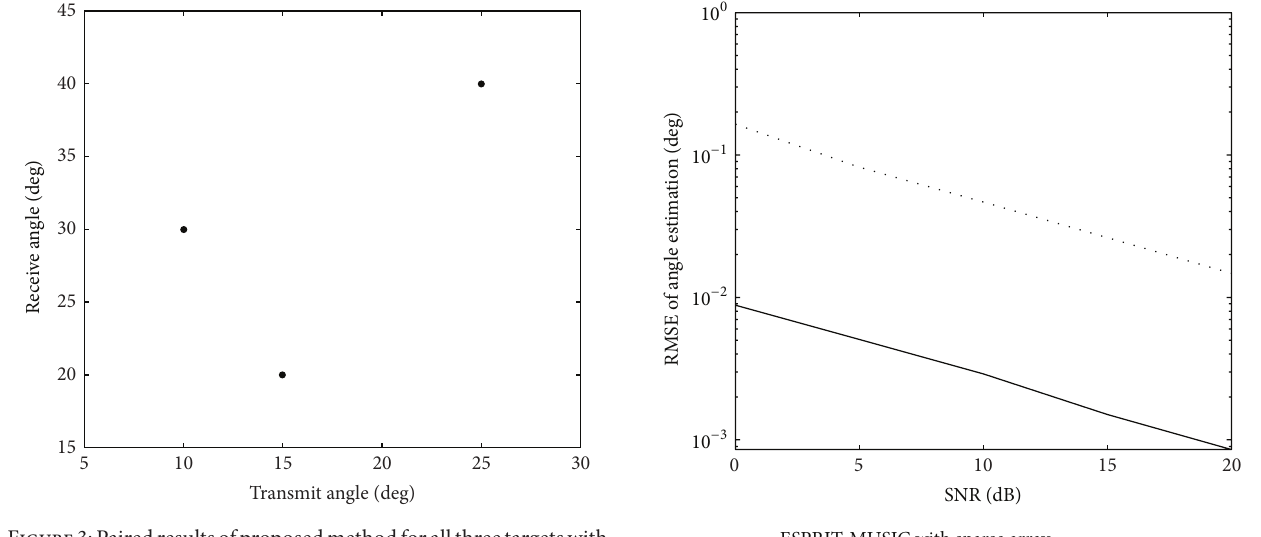
Figure3:Pairedresultsofproposedmethodforallthreetargetswith SNR = 0 dB.